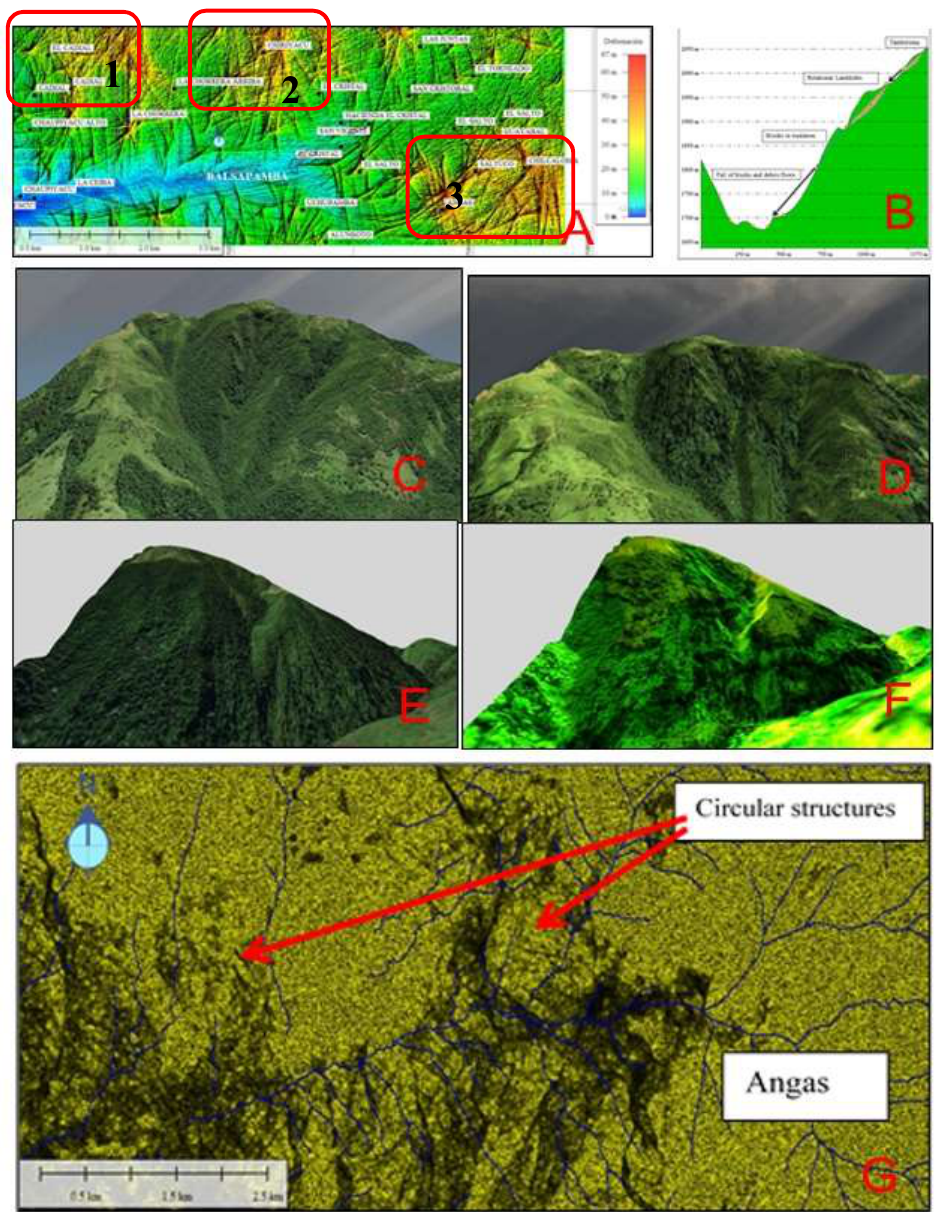
Figure 7. Zone 1: Located between the towns of El Cadial, Chilcaloma, and Angas, in the province of Bol í var. There are three morphological deformation plates. ( A1 ) El Cadial-La Chorrera–La Chorrera de Arriba (340 ha), ( A2 ) Chiriyacu (262 ha), ( A3 ) Angas–Saltuco–Chilcaloma–El Salto (370 ha). In these areas, the mountains are possibly fractured by the Balzapamba Intrusive. ( B ). Detail the surface-relief deformations and structural lineaments. ( C , D , E , F ) Field check of the geoforms with real images without and with the application of the proposed methodology at scale 1/10,000. The response of the model was evidence in more than 300 control points. ( G ) Circular structures obtained with the proposed methodology of hidden geomorphological